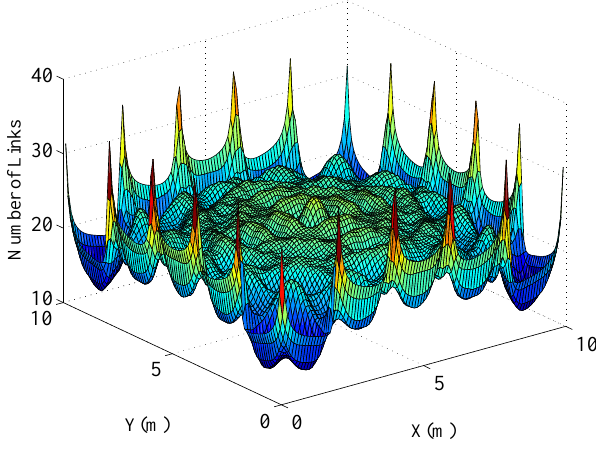
Figure 4. Distribution of M ( x t ) in the monitored region.